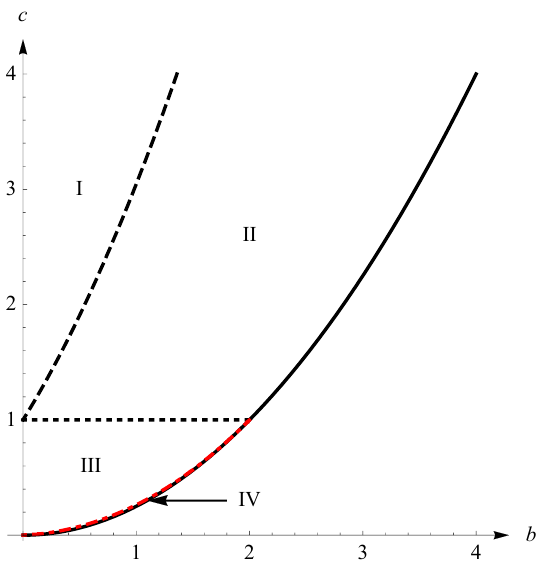
Figure 10. Curves of b 2 − 4 c = 0 (solid line), c = 1 (dot line), p ( b , c ) = 0 (dash line) and q ( b , c ) = 0 (red dot-dash